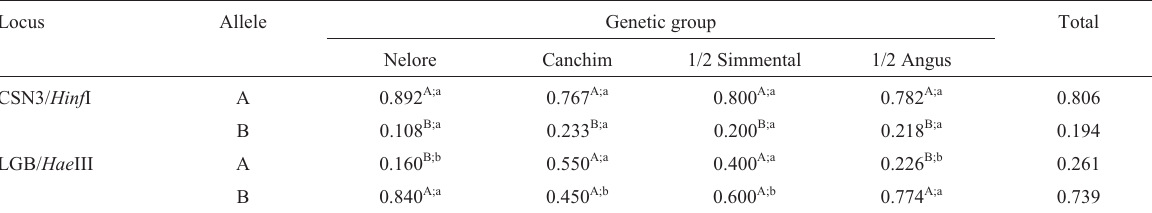
Table 1 - Allele frequencies of the CSN3/ Hinf I and LGB/ Hae III loci obtained for the four genetic groups and for the sample as a whole. Locus Allele Genetic group